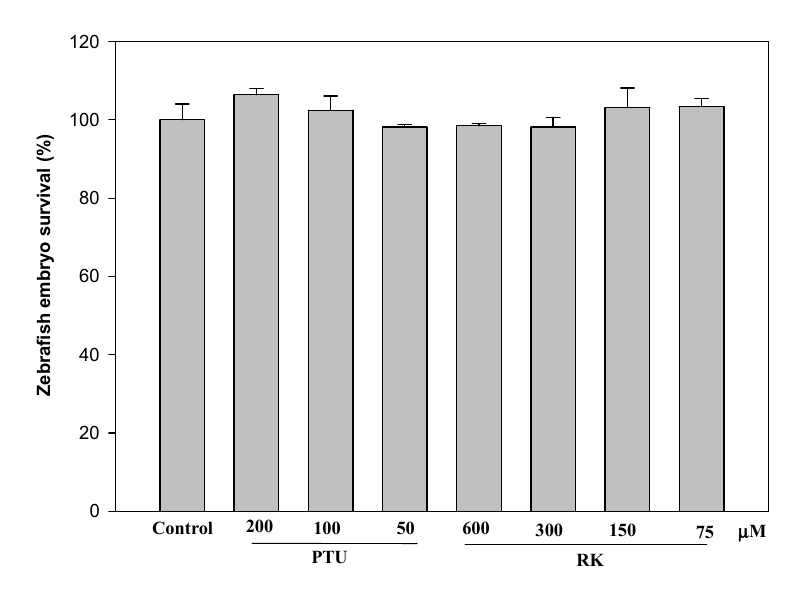
Figure 5. Evaluation of Depigmenting Activity of RK in Zebrafish. A total of 100 synchronized embryos were treated with drugs from 9 to 48 hpf (hours post fertilization), and normally developed embryos were collected to calculate embryo survival ( A ). Melanin pigment was photographed ( B ) and its quantity was determined by a photometric method ( C ), as described in the Experimental Section. For assays of tyrosinase activity ( D ), 250 µg of total protein from lysates of 100 zebrafish larval was incubated with 2.5 mM of L -DOPA, and the resulting dopachrome was quantified by a photometric method, as described in the Experimental Section. Averaged data (n = 3) are presented with an error bar of SD. A value of p < 0.05 (*) by Student’s t -test by comparing the data with those for control was considered statistically